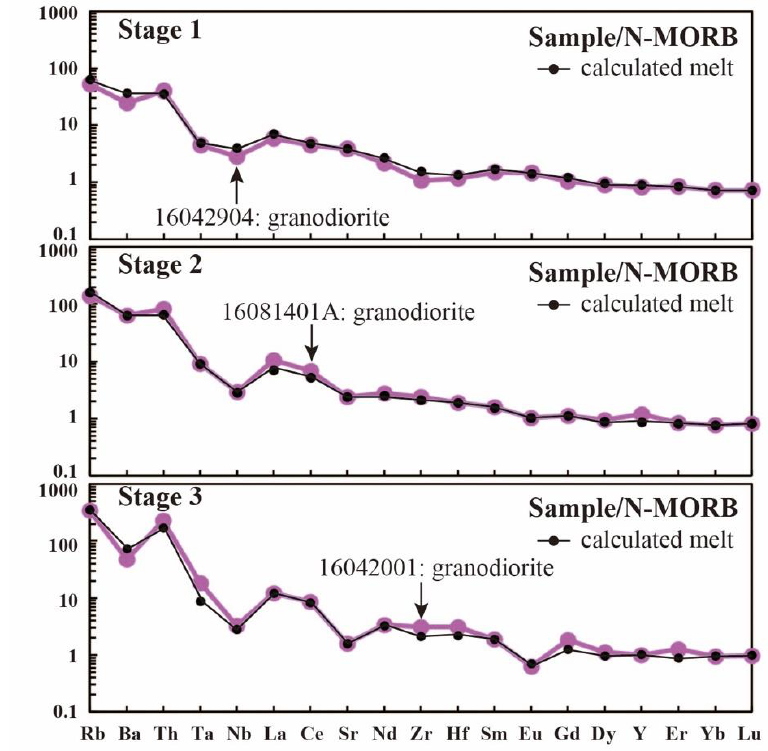
Figure 10. Results of fractional crystallization by the Rayleigh fractionation model using the results of mass balance calculation and partitioning coefficient. Normalized values of C1 chondrite are after the published paper [14]. The partitioning coefficients are listed in Table S4. The calculated magmas are identical with the granodiorite, suggesting that the granodiorite was differentiated from Fn-Gab as the parental magma.